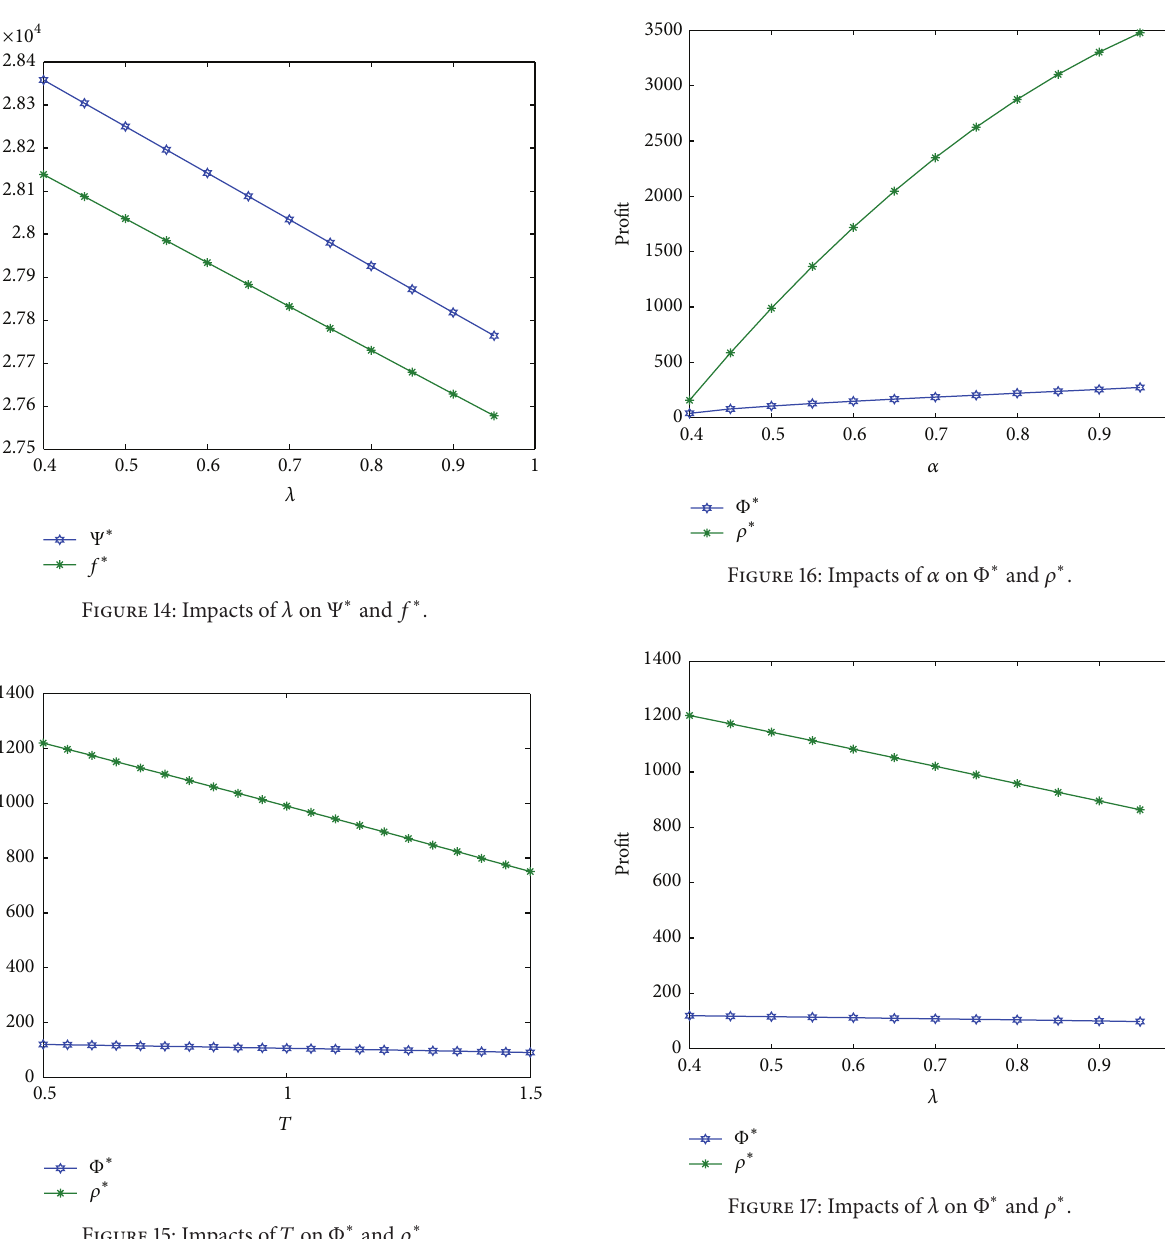
Figure 15: Impacts of 𝑇 on Φ ∗ and 𝜌 ∗ .